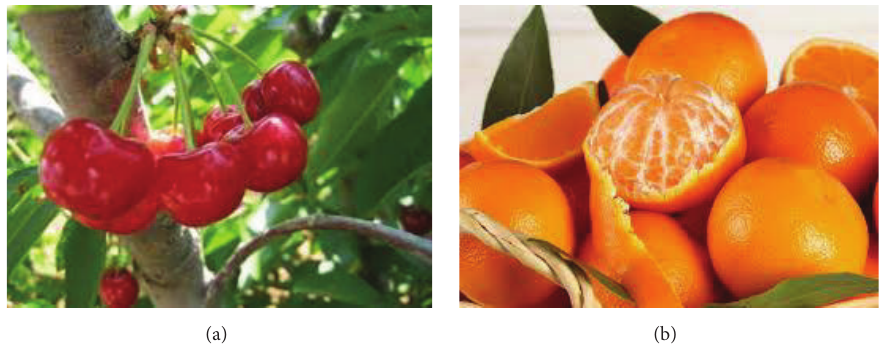
Figure 3: Structure of nutraceutical fruits for brain health: (a) cherries and (b)